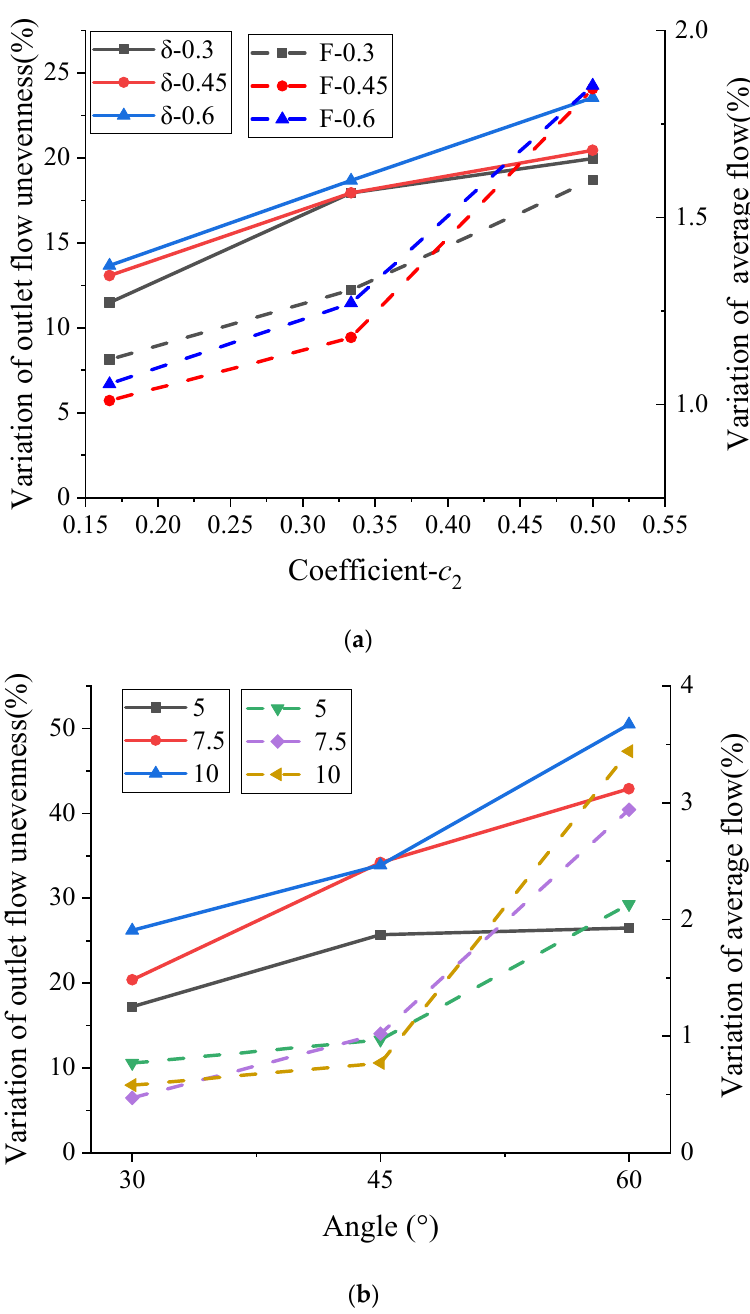
Figure 12. Variation of the outlet flow unevenness and average flow: ( a ) curved reflux groove; ( b ) rectangular reflux groove.